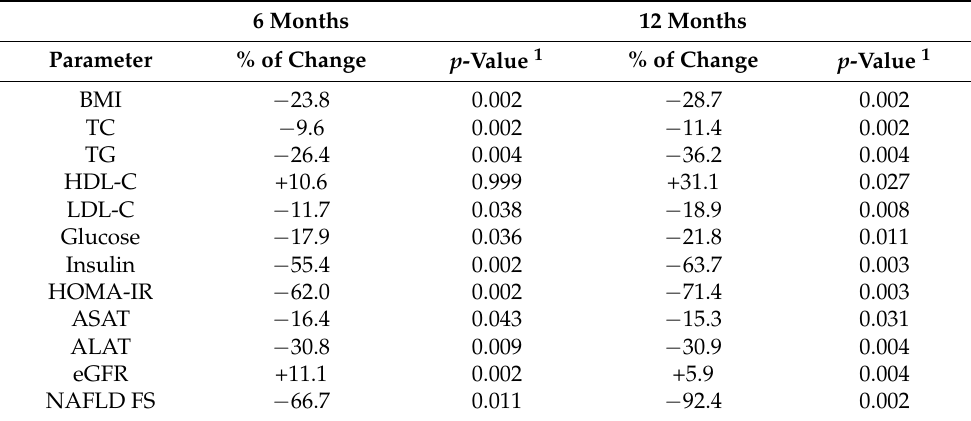
Table 2. Effect of bariatric surgery on the clinical parameters of the patients in comparison to the baseline